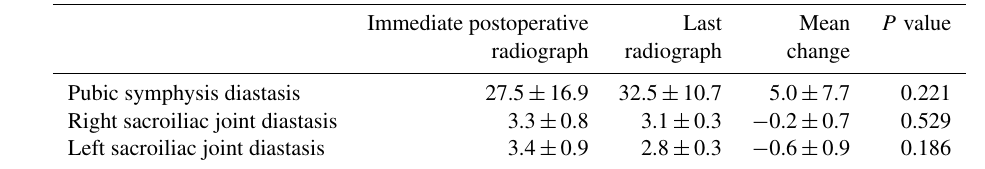
Table 2. Radiographic outcomes.